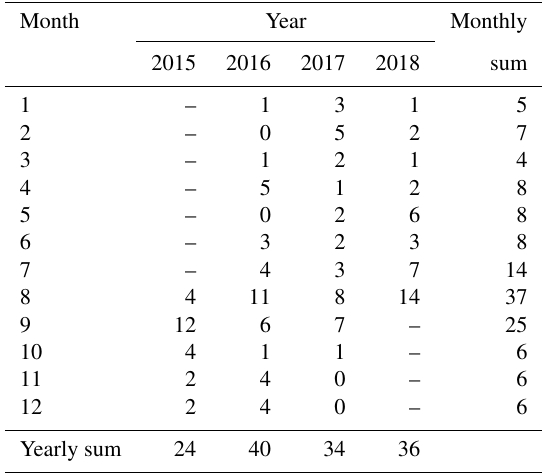
Table 1. Summary of precipitation events by month and year. Table 2. Basic statistics of stable water isotope data based on monthly